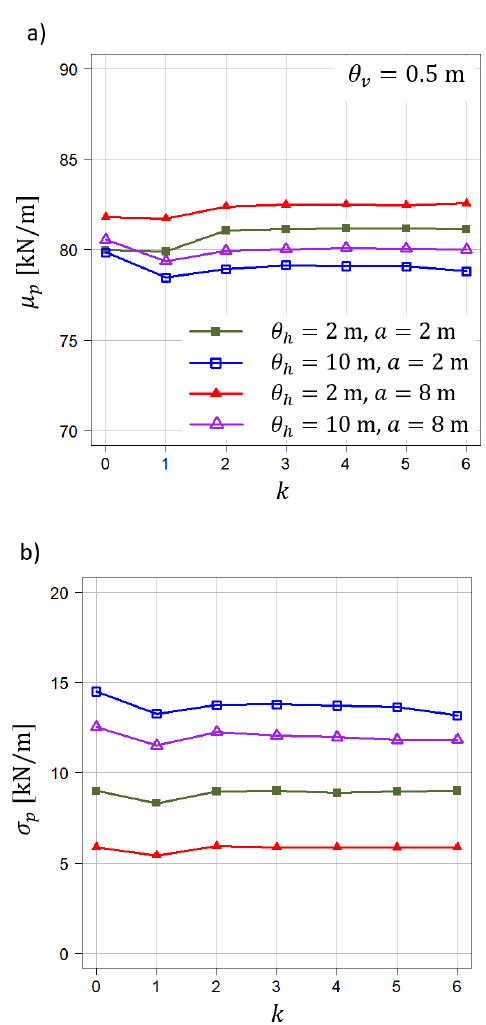
Figure 4: Bearing capacity mean values as a function of covariance matrix iteration number (a). Bearing capacity standard deviations as a function of covariance matrix iteration number (b). Case k =0 is for the constant covariance matrix. Results for two-layered soil, vertical scale of fluctuation θ =0.5 m,, foundation width b =1 m and v averaging lengths a =2 m and a =8